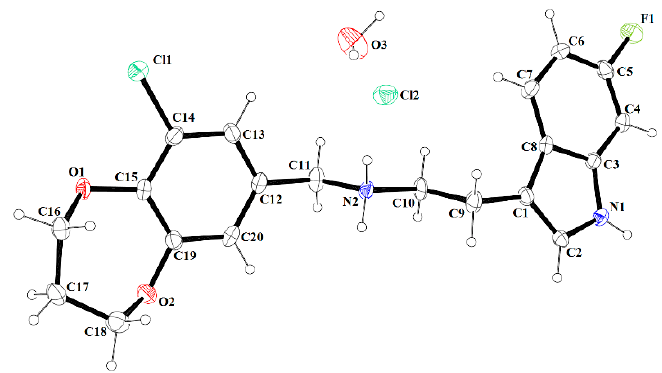
Figure 2. The molecular structure of D2AAK5 with displacement ellipsoids drawn at the 50% probability